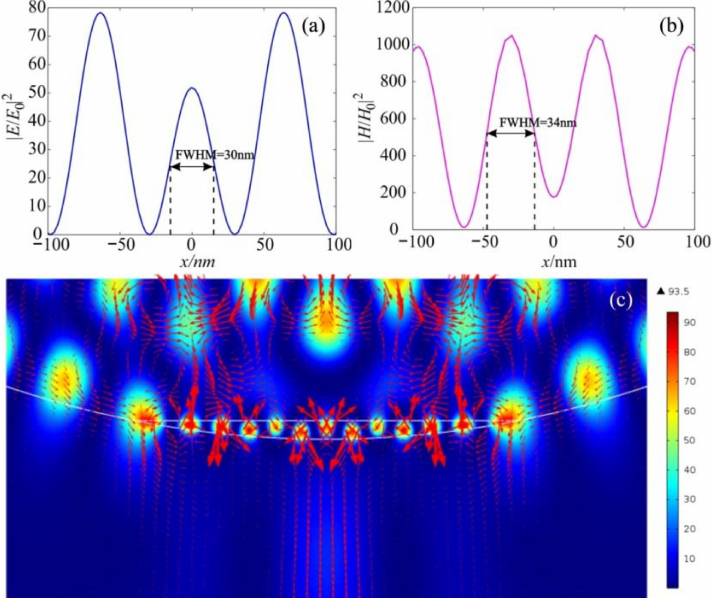
Figure 9. Field intensity distribution along the extrema of the hot spots for the ( a ) electric and ( b ) magnetic components; ( c ) Poynting vector energy